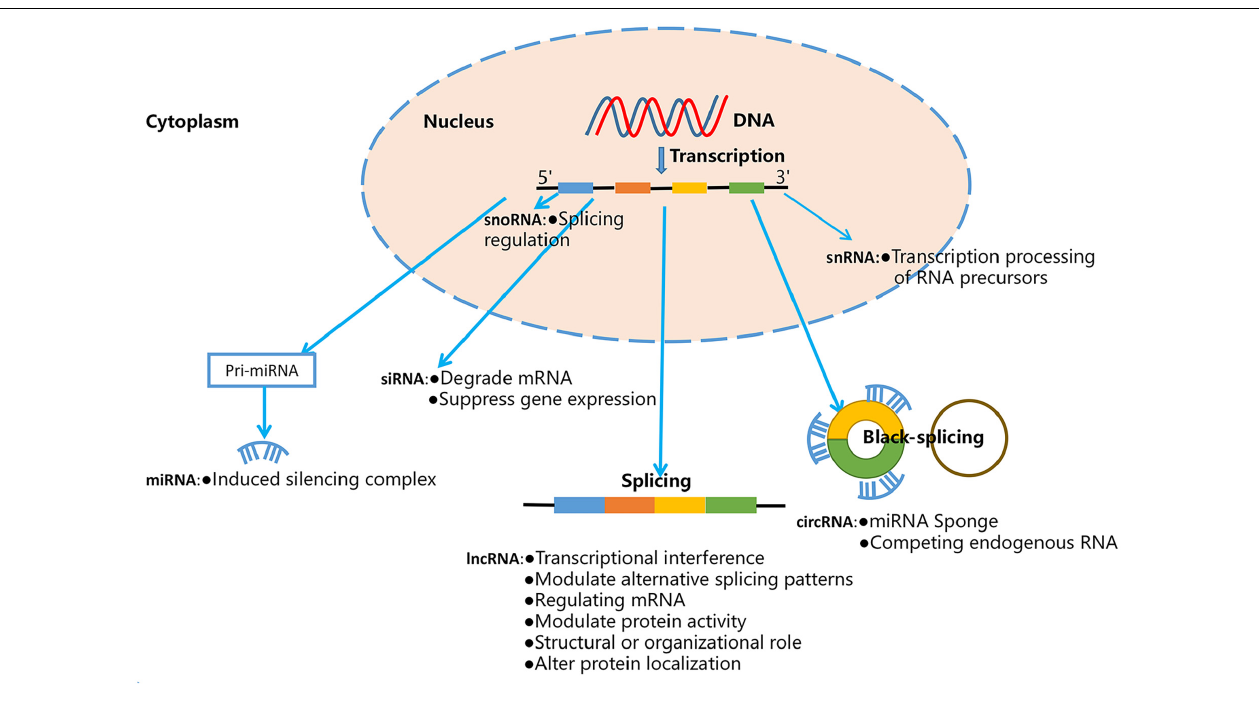
FIGURE 1 | The biological source and function of